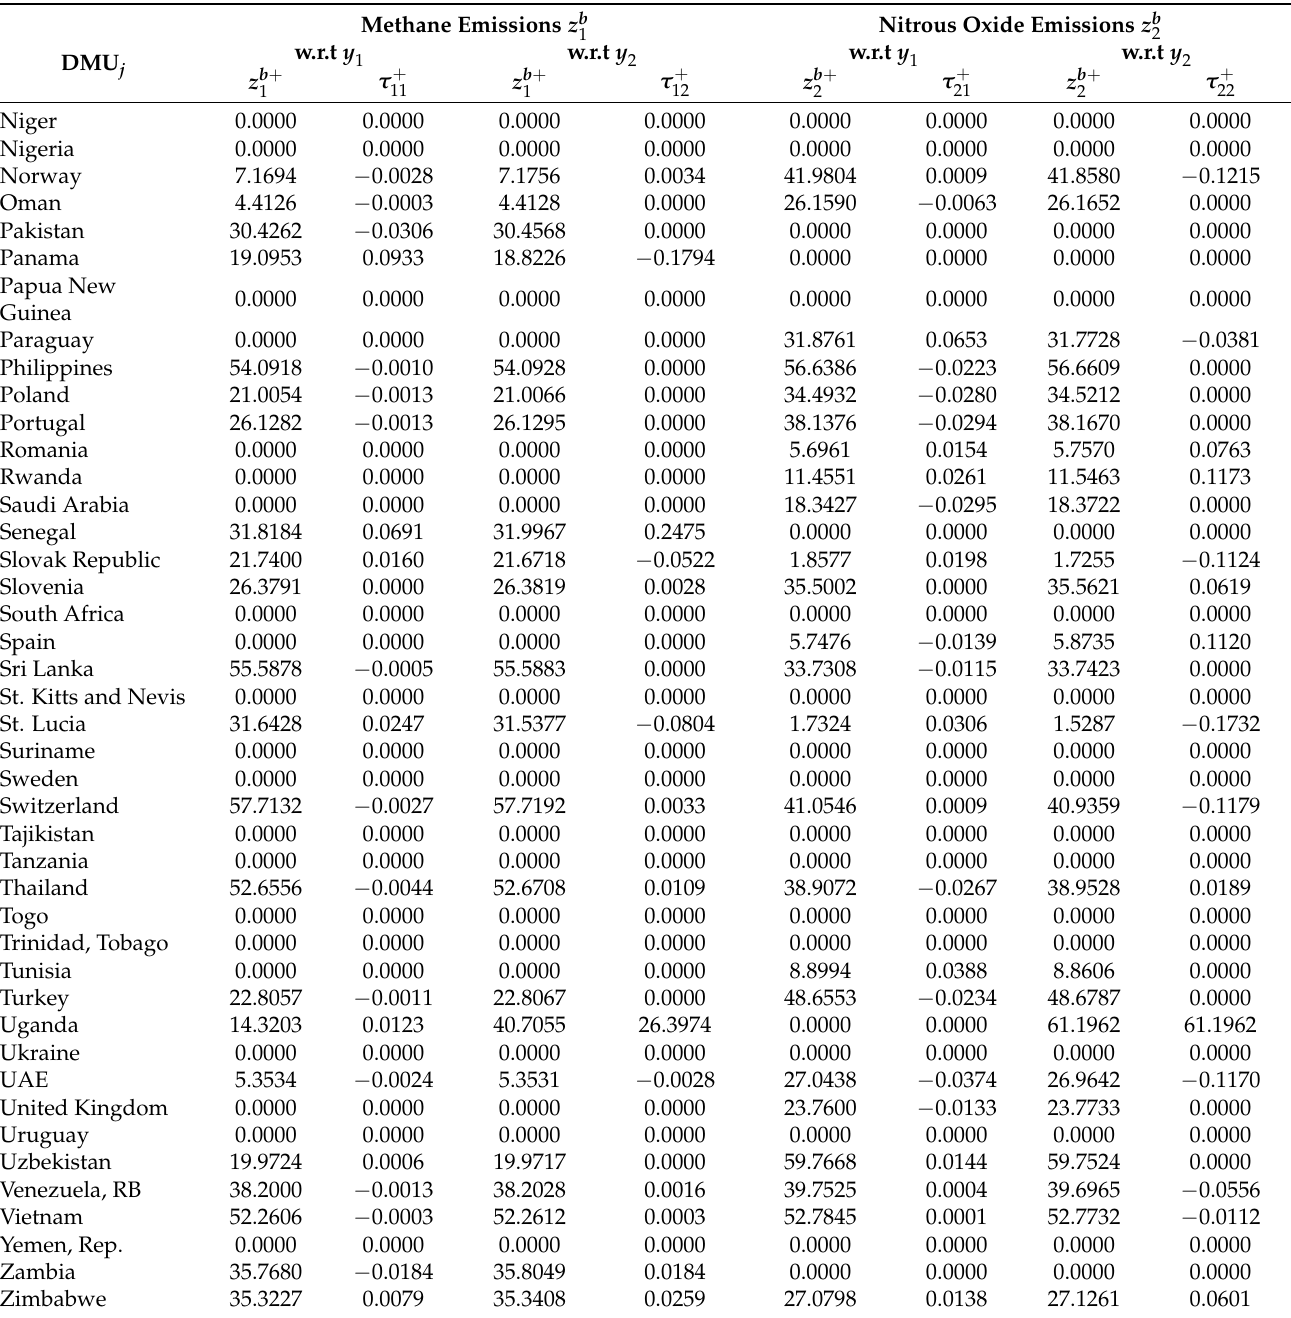
Table A3. Trade-off effects on the methane ( z b